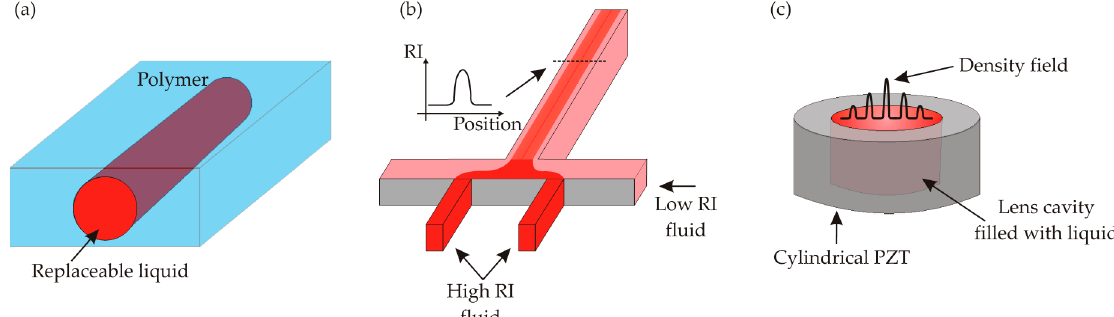
Figure 3. ( a ) A liquid core waveguide which can be tuned by replacing the liquid in the hollow channel; ( b ) an optofluidic GRIN lens configured by two miscible fluids; and ( c ) an acoustics-driven gradient refractive index lens.